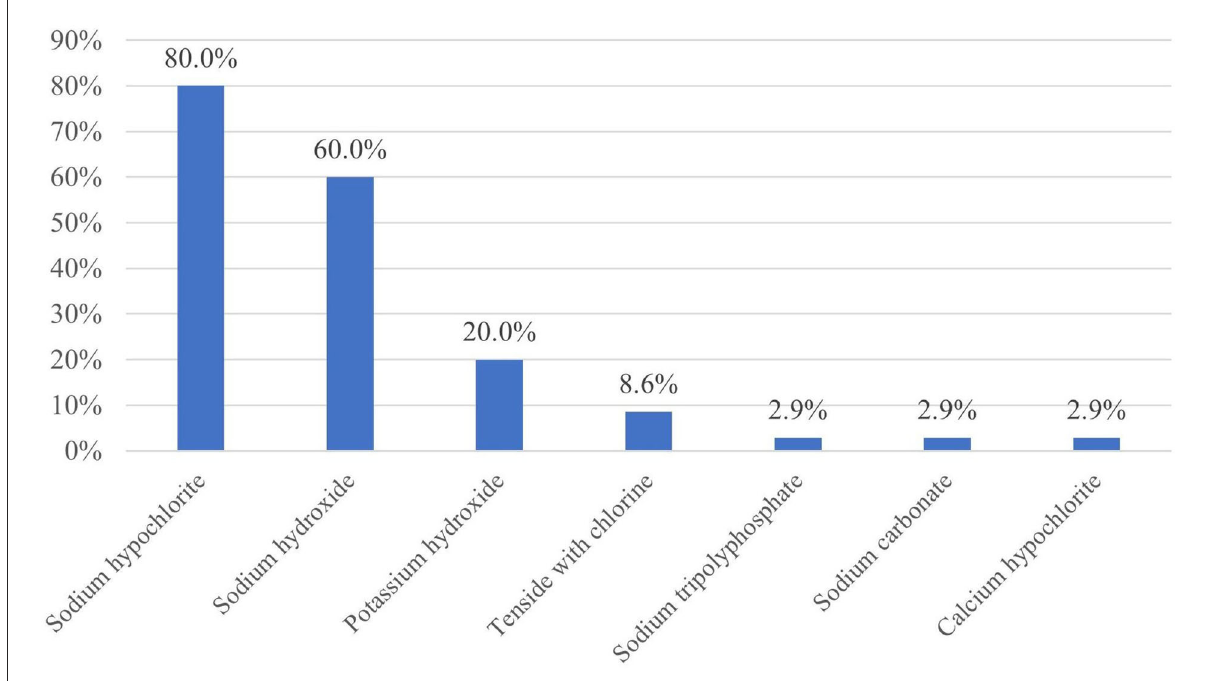
FIGURE4 Active ingredients of the caustic detergents ( n = 35).